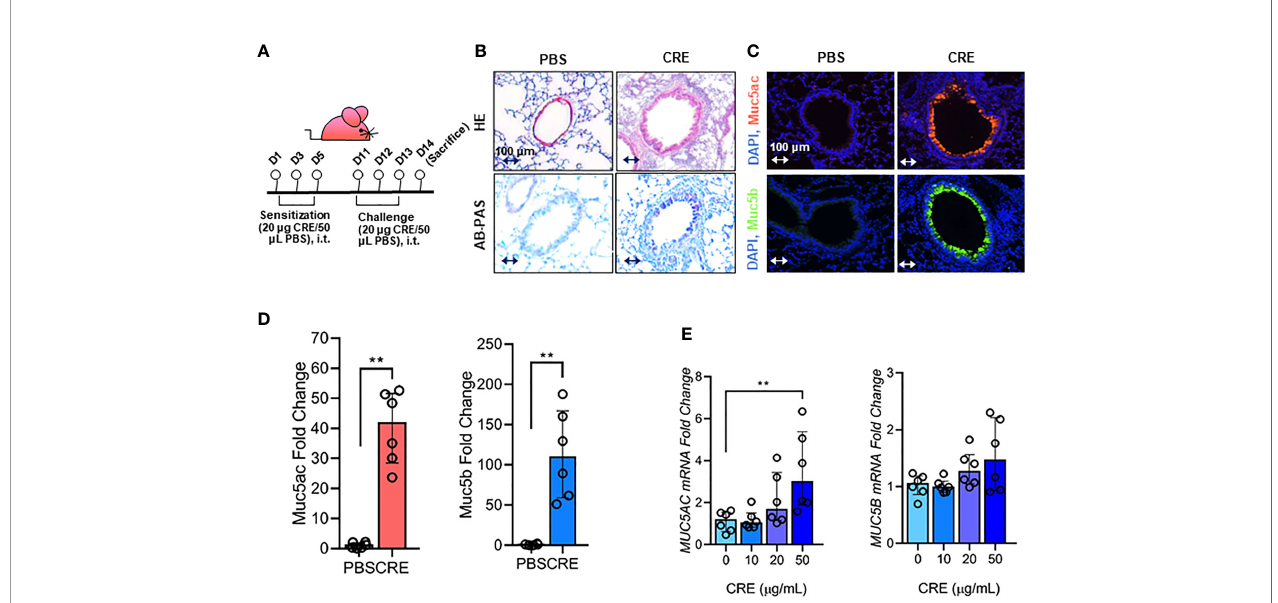
FIGURE 1 | Cockroach allergen exposure can induce airway in fl ammation and mucus production. (A) Experimental scheme for cockroach allergen-induced mouse model of asthma. (B) Histological examination of mouse paraf fi n lung sections stained with hematoxylin and eosin (H&E, upper panel) and Alcian Blue periodic acid- Schiff (AB-PAS, lower panel). (C) Representative immuno fl uorescence images of Muc5ac (upper panel) and Muc5B (lower panel) in the airways of cockroach allergen-induced mouse model. (D) Quantitative analysis of [ (C) , n = 6]. (E) RT-PCR analysis of Muc5ac and Muc5B in HBECs treated with cockroach extract (CRE) at different concentrations for 24 h (n = 6). Data represent as medians with interquartile (IQR). ** P <